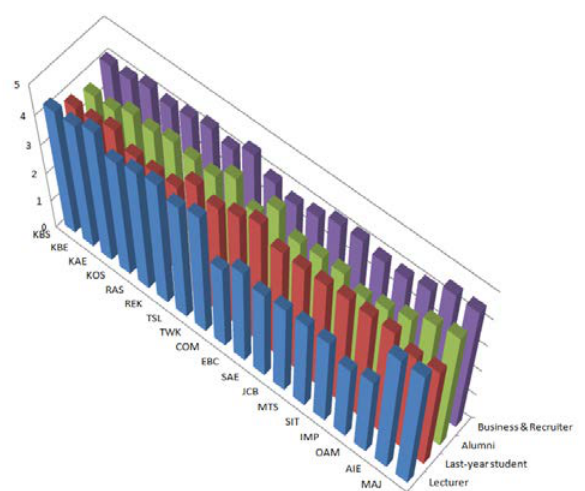
Figure 6. Multivariate cube integrated